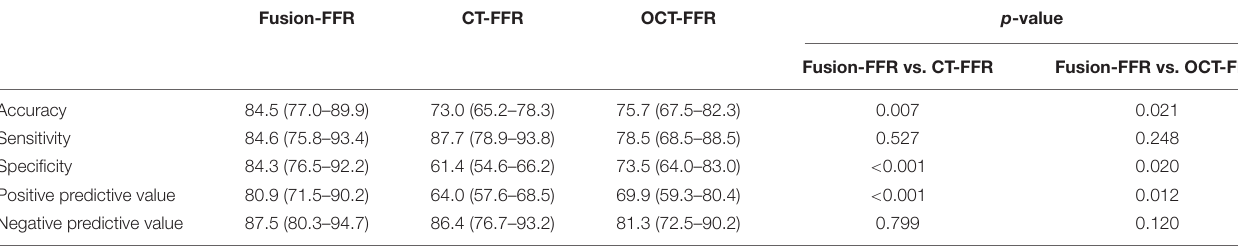
TABLE 3 | Diagnostic performance of CFD-based computational FFRs in assessing functionally significant